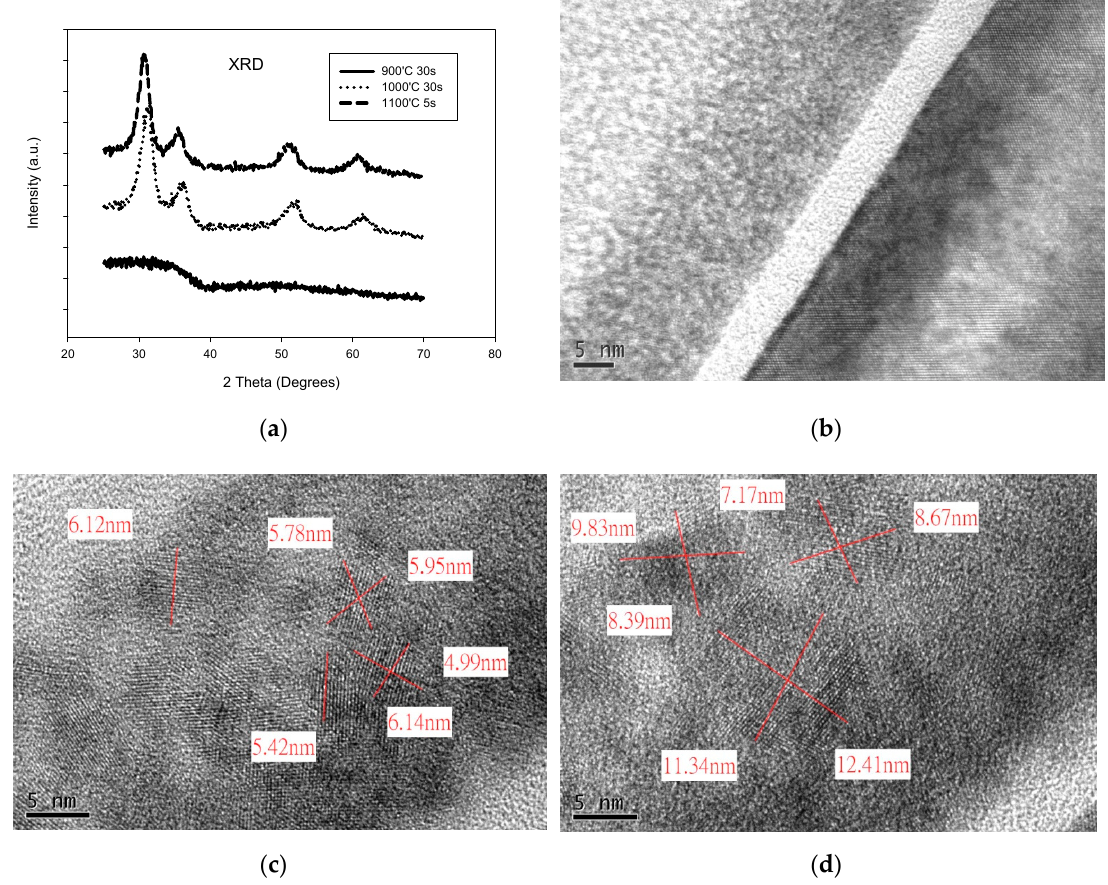
Figure 6. ( a ) XRD analysis comparison of HfAlO films with different anneal temperatures; ( b ) TEM image of SAHAOS capacitor with 900°C 30sec PMA; ( c ) TEM image of SAHAOS capacitor with 1000°C 30sec PMA; ( d ) TEM image of SAHAOS capacitor with 1100 °C 5sec PMA.